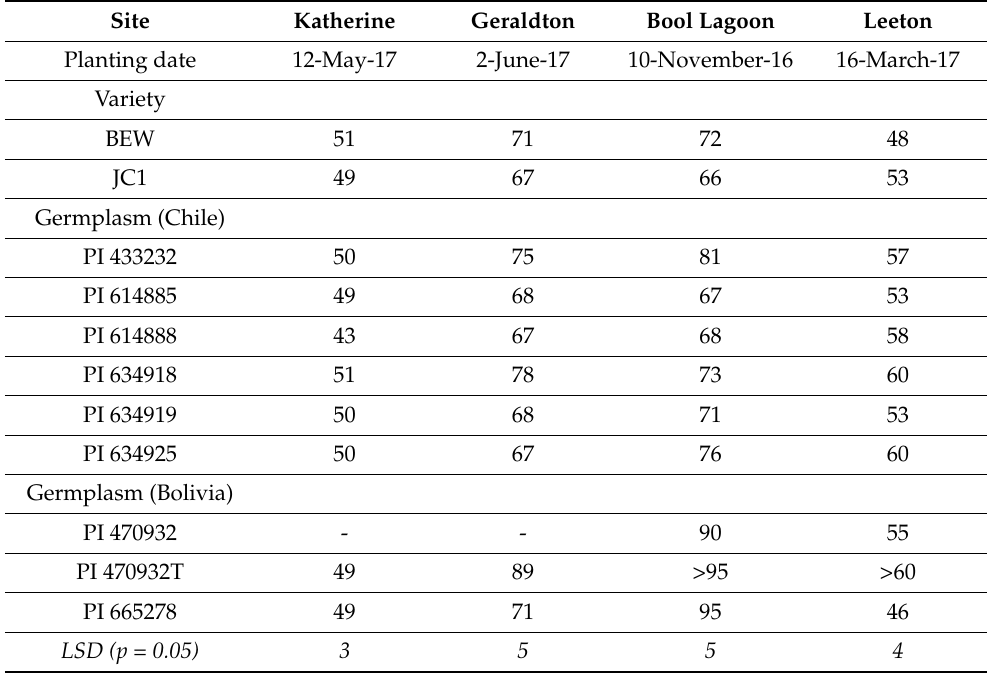
Table 6. Heatsums (sum of daily mean temperatures) from planting to commencement of flowering of varieties and germplasm lines and daylength (hours:minutes) between planting and flowering at selected trial sites (arrows indicate if daylength is increasing or decreasing).